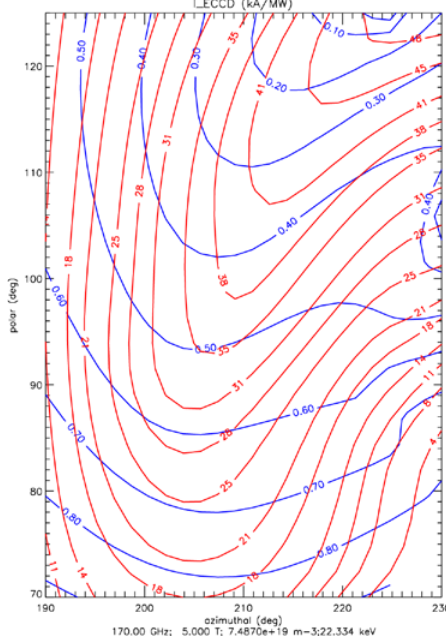
Figure 6: Contour plot of the EC driven current from a scan of launching polar and azimuthal angles, the level of I_ECCD (red) at each radial location (blue). EC wave launched from the LFS outside launch at 170GHz in CFETR baseline scenario.